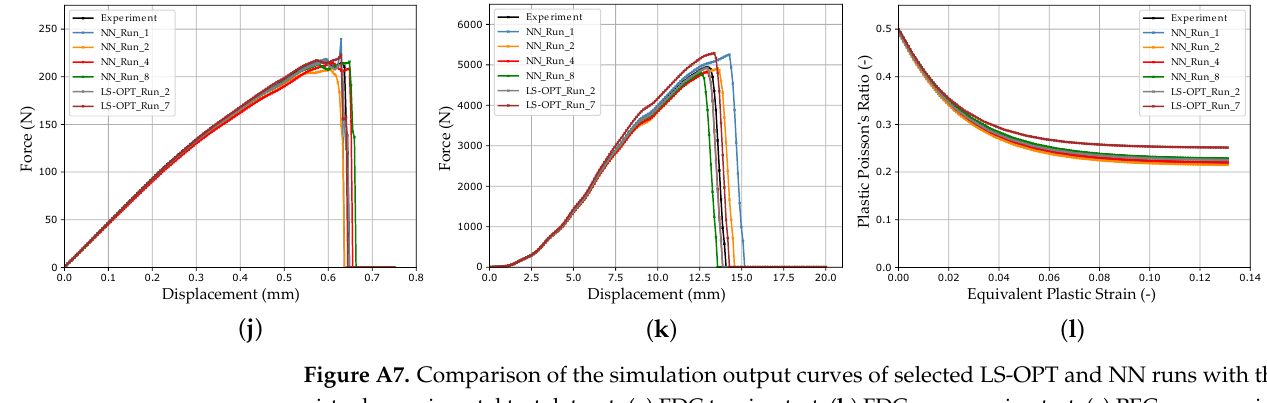
Figure A7. Comparison of the simulation output curves of selected LS-OPT and NN runs with the virtual experimental test dataset: ( a ) FDC tension test; ( b ) FDC compression test; ( c ) PEC compression test; ( d ) FDC tension tests V1; ( e ) FDC tension tests V2; ( f ) FDC tension tests V3; ( g ) FDC tension tests V4; ( h ) FDC bending test ( i ) FDC shear1 test; ( j ) FDC shear2 test; ( k ) FDC punch test; and ( l ) PEC punch